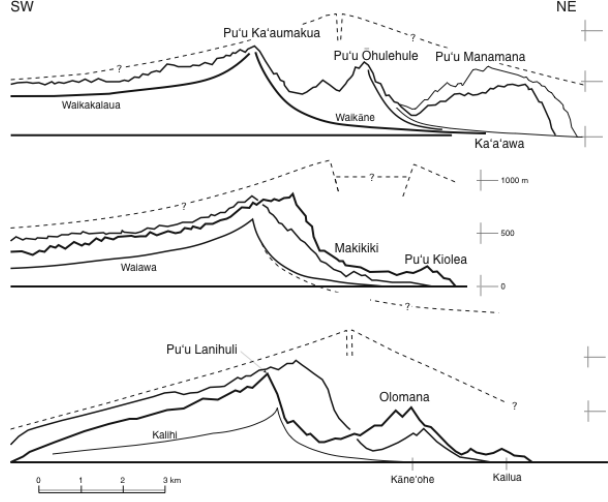
Fig. 15. This diagram (from Wirthmann and Hueser, 1987) demonstrates the outcome of breakdown of a Hawaiian shield volcano. The diagram shows three topographic profiles crossing from SW to NE through the windward Ko`olau mountain range of O`ahu Island. The slope reduction to this level of contemporary topography took 2.6 million years on the rain- and trade wind exposed west side of the island. In addition to regular stream erosion there were sudden break-offs of whole slope segments that rolled into the ocean, where they now form small, offshore islands.